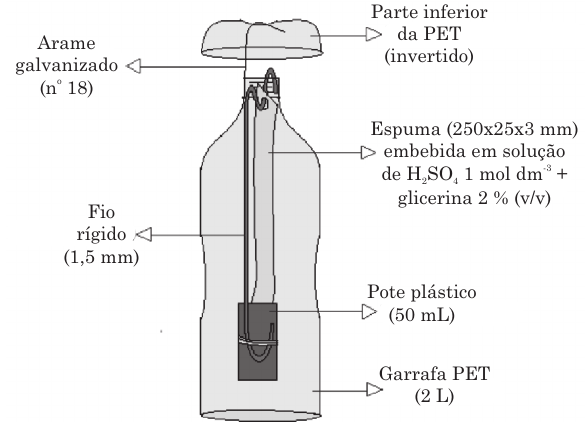
Figura 1. Esquema da câmara coletora de N-NH 3 semiaberto livre estático “SALE” (Araújo et al.,